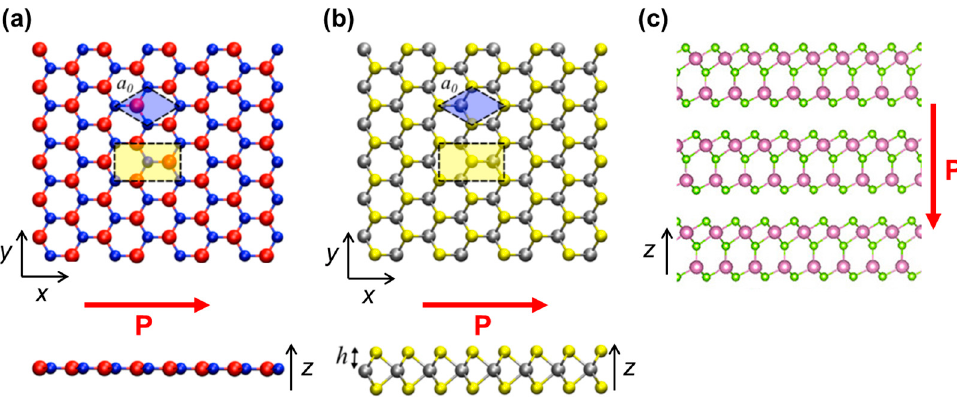
Figure 6. Top and side views of atomically thin ( a ) h-BN and ( b ) 2H-MoS 2 [117]. ( c ) Side views of the atomic structure of layered In 2 Se 3 . The B, N, Mo, S, Se, and In atoms are red, blue, silver, yellow, green, and pink, respectively [119]. The arrows show the axes and direction of piezoelectric polarization. Reproduced with permission. Copyright (2012, 2017) American Chemical Society.